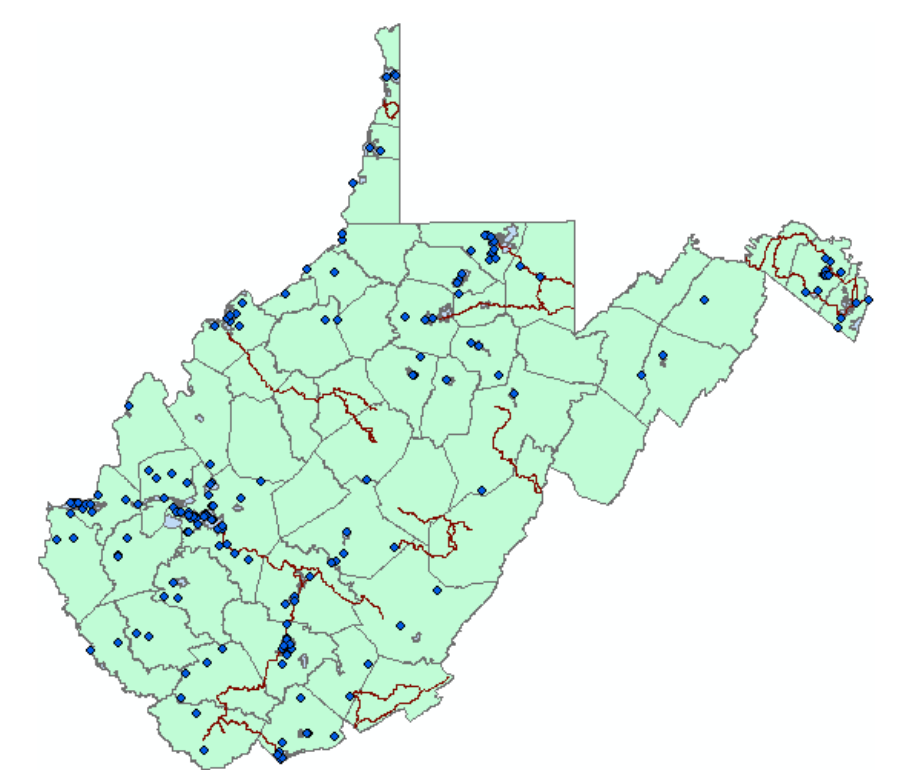
Figure A2. Map of male pedestrian fatalities in WV, 2009–2019. Burgundy lines represent major roadways. Blue diamonds represent individual crashes. Blue-grey areas represent designated towns or cities.